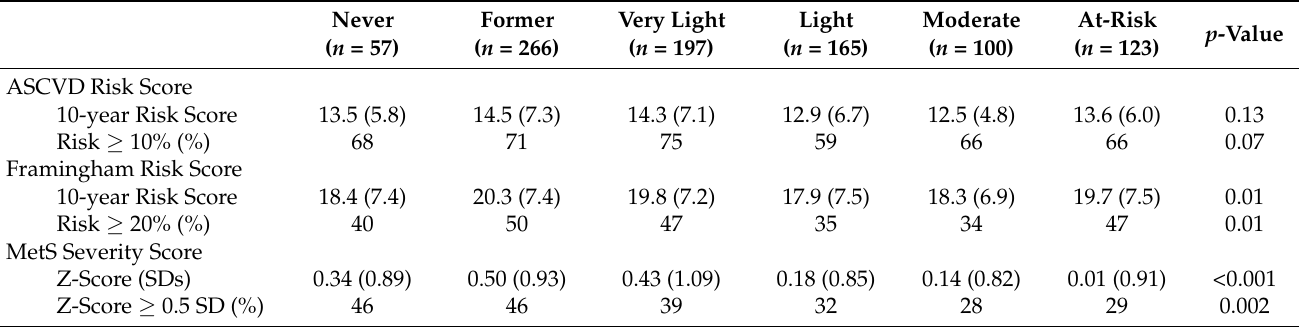
Table 4. CVD risk scores and proportions above select risk thresholds by drinking group.